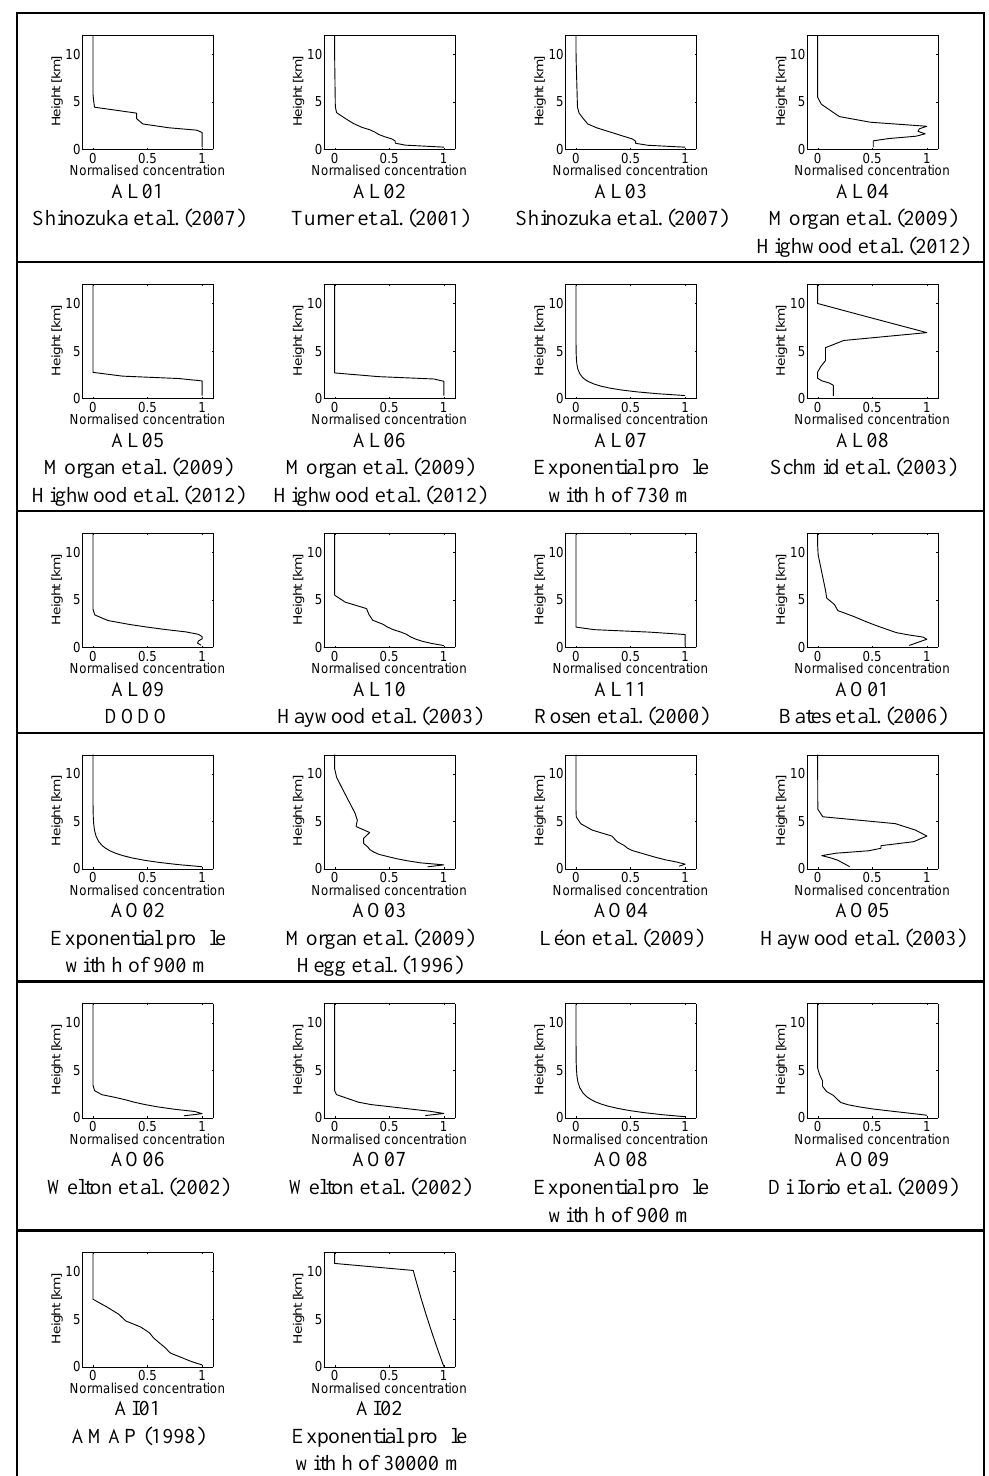
Fig. 3. Normalised aerosol concentration profiles used in this study for each region, and their literature sources. Where an exponential profile is used, w 0 s = e − z/h where w 0 s is the normalised aerosol mass mixing ratio; z is height and h is the scale height, both in